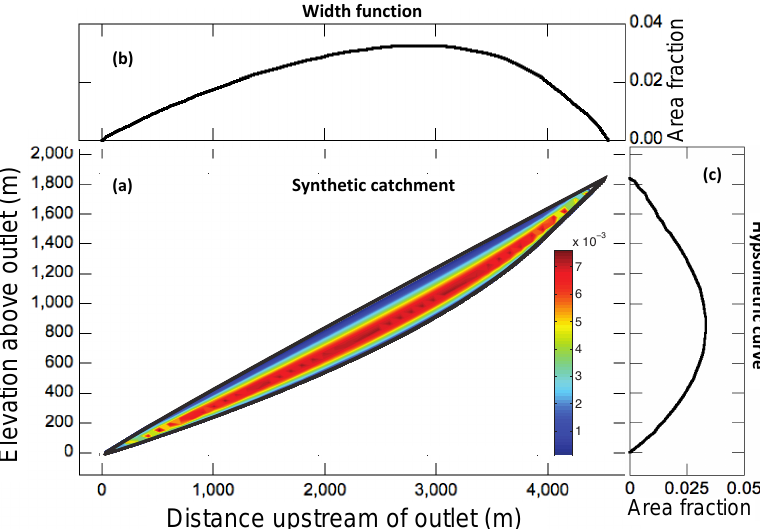
Figure 10. Fully synthetic joint distribution of elevation and travel distance for catchment the size of Inyo Creek. In (a) , channel and ridge profiles are defined by Eqs. (9) and (10), and area density (color bar) is given by Eqs. (7) and (11). Side panels show area density projected on distance axis to create width function (b) and projected on elevation axis to create hypsometric curve (c) .